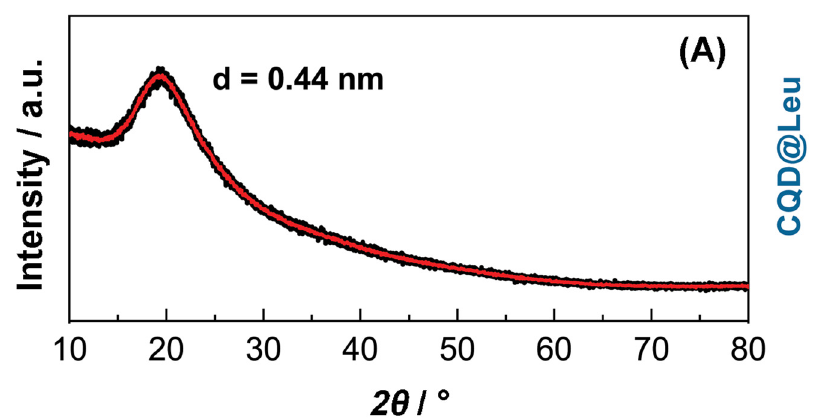
Figure 5. XRD pattern of Figure 5. XRD pa tt ern of CQD@Leu.